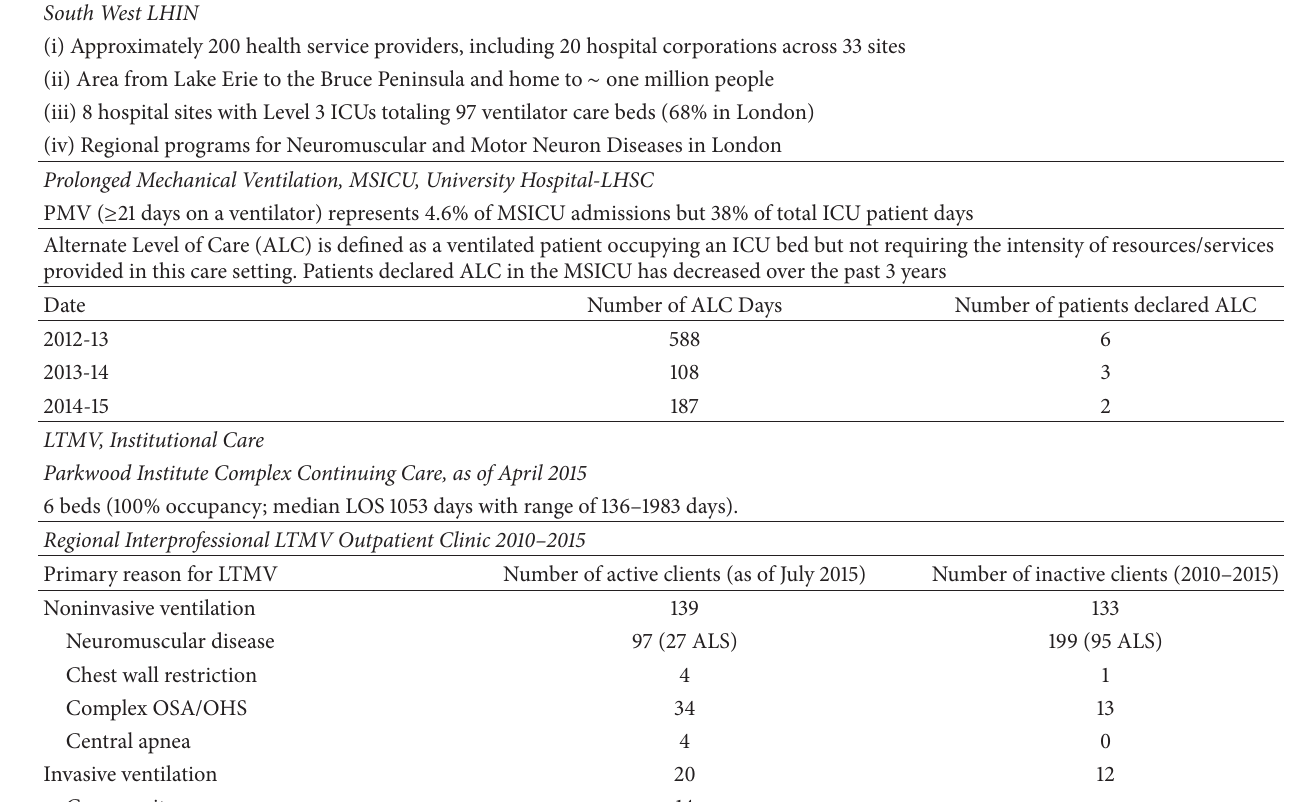
Table 1: Selected program